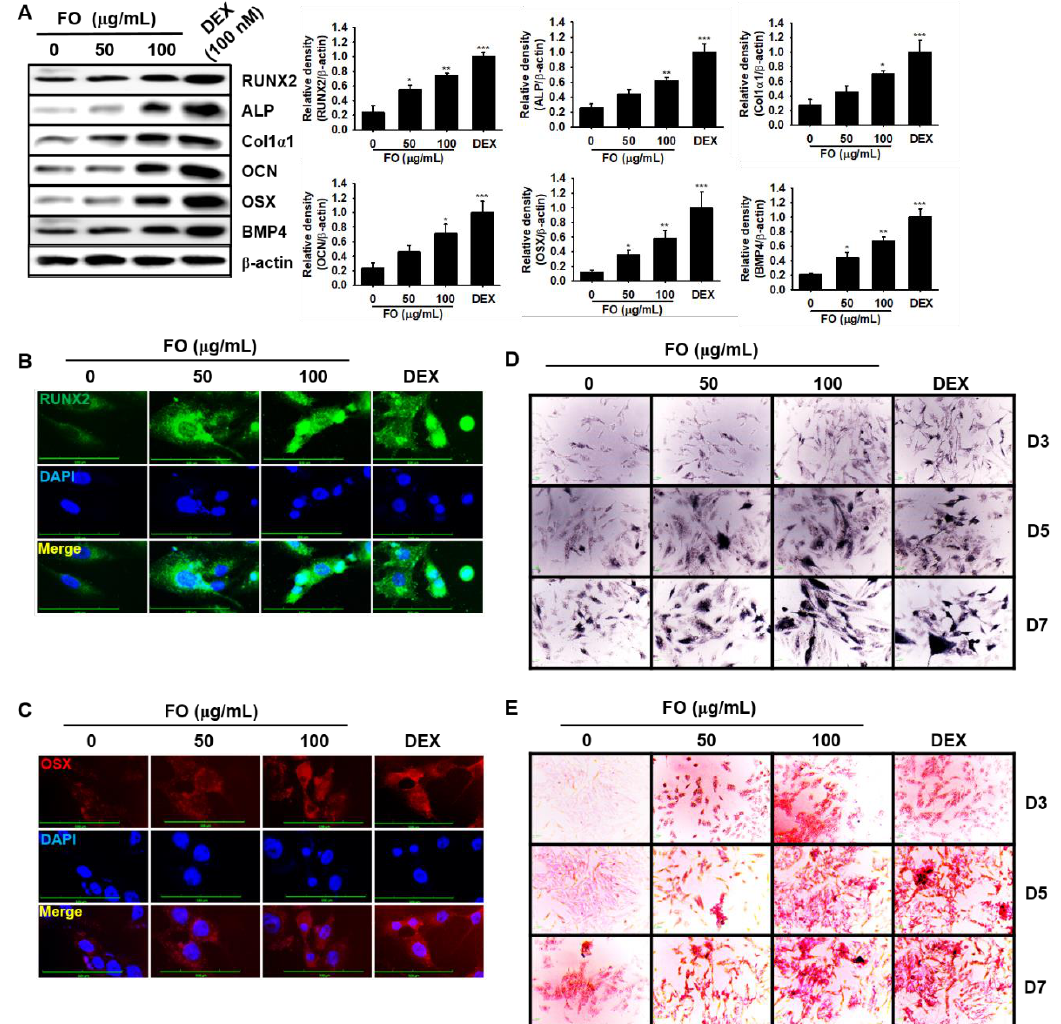
Figure 4. FO activates osteoblast-specific protein expression and mineralization/calcification in osteosarcoma MG-63 human osteoblast-like cells. ( A ) MG-63 cells (3 × 10 3 cells/mL) were seeded overnight and then treated with FO (50 µg/mL and 100 µg/mL) or DEX (100 nM) for 7 days. Protein was extracted and western blotting analysis was performed using each specific antibody. β -Actin was used as the internal control of protein expression. All protein expression was normalized by the density of β -actin. The nuclear localization of runt-related transcription factor 2 RUNX2 ( B ) and osterix OSX ( C ) was measured by immunostaining. ( D ) ALP activity (mineralization) was measured using a TRACP & ALP assay kit. ( E ) In vitro calcification was detected by alizarin red staining. Significant di ff erences among the groups were determined using the one-way ANOVA followed by Bonferroni correction. All data are presented as mean ± SEM (*** p < 0.001, ** p < 0.01, and * p < 0.05 versus untreated group). FO; fermented extract of C. gigas and DEX; dexamethasone.